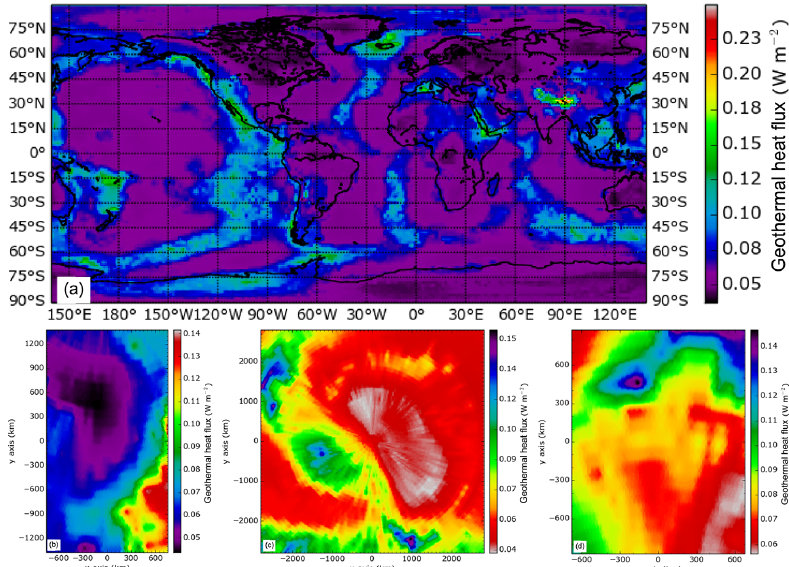
Figure 12. Panel (a) shows the geothermal heat flux (Shapiro and Ritzwoller, 2004) on a global regular 1 ◦ × 1 ◦ longitude–latitude grid; the continental contours are plotted black. This geothermal heat flux has been mapped with optimal projections on a 5km × 5km ISM grid for Greenland (b) , a 20km × 20km ISM grid for Antarctica (c) and a 5km × 5km ISM grid for the Antarctic Peninsula (d)